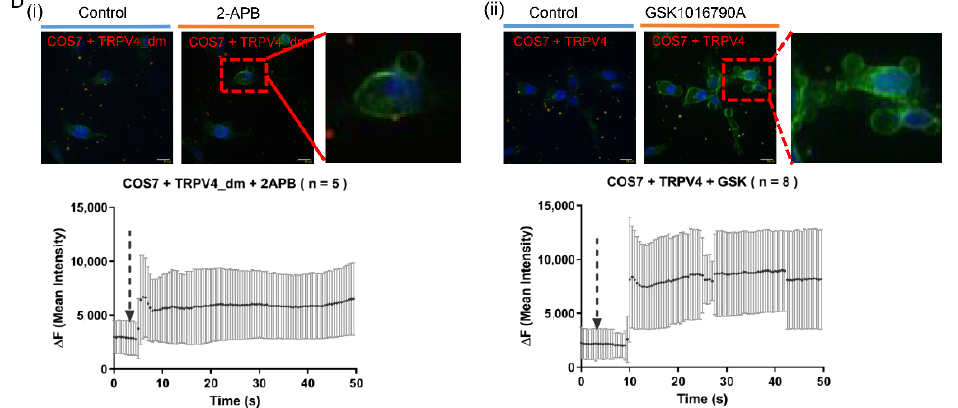
Figure 2. Functional TRPV4 induces cell exocytosis in heterogenous expression system. ( A ) Time-lapse of scanning disk confocal images of 3T3 cells transiently transfected with TRPV4 upon GSK1016790A (20 nM) exposure. ( B ) Time ‐ lapse of scanning disk confocal images of 3T3 cells transiently transfected with TRPV4 carrying double mutations of N456H/W737R (TRPV4_dm) upon 2-APB (50 µ M) application. ( C ) Representative scanning disk confocal images (upper row) and calcium imaging (lower row) of heterogenous TRPV4 mutation ( i ), as well as TRPV4 ( ii ) expressing in HEK293T cells ( C ) and COS7 cells ( D ) upon 2-APB (50 µ M) ( i ) and GSK1016790A (20 nM) ( ii ) applications.